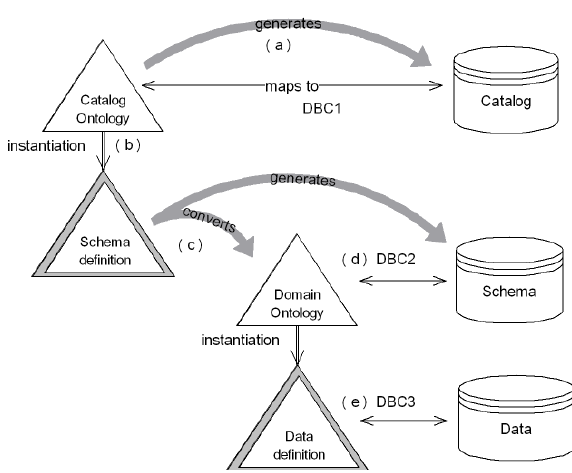
Fig. 7. Data flow